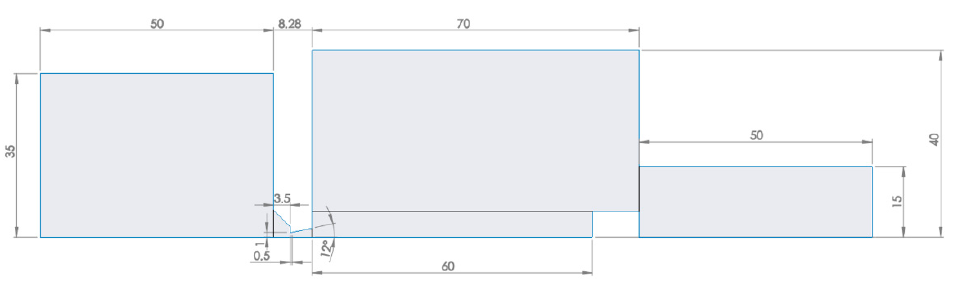
Figure 9. 2D model of the experimental chamber.